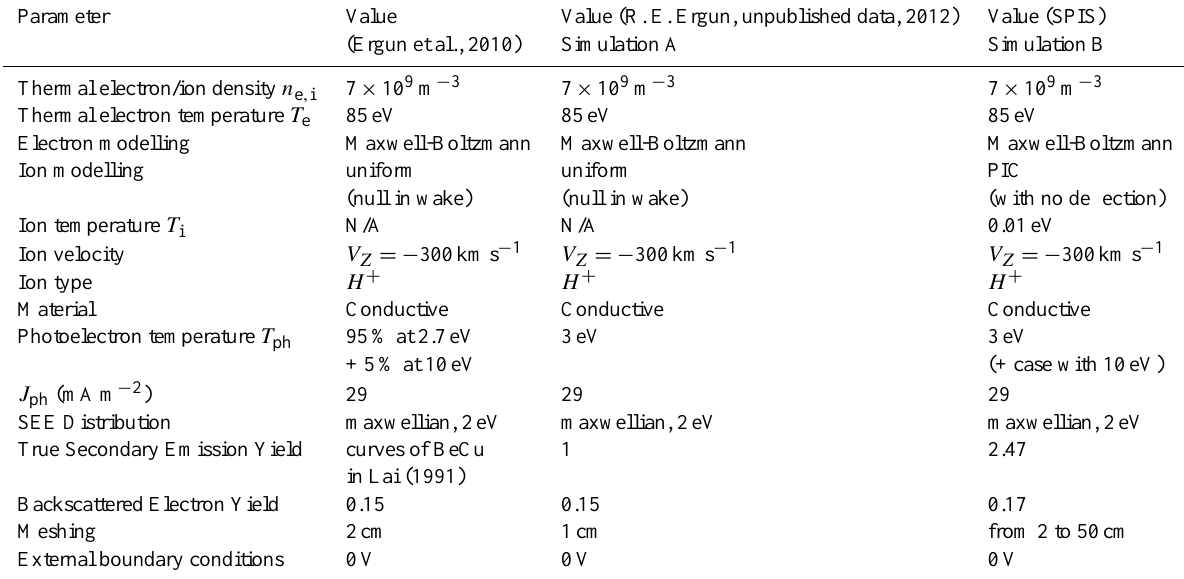
Table 1. Input parameters for the cross-comparison test